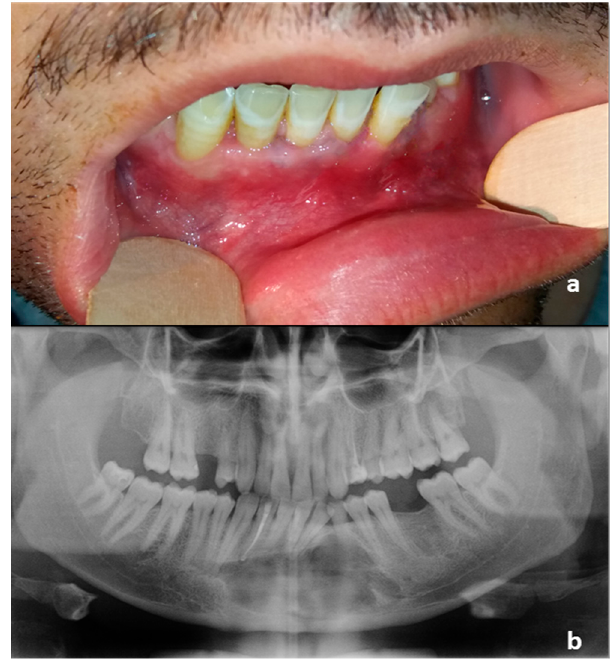
Figure 3. Preoperative pictures. ( a ) Frontal view; ( b ) side view.